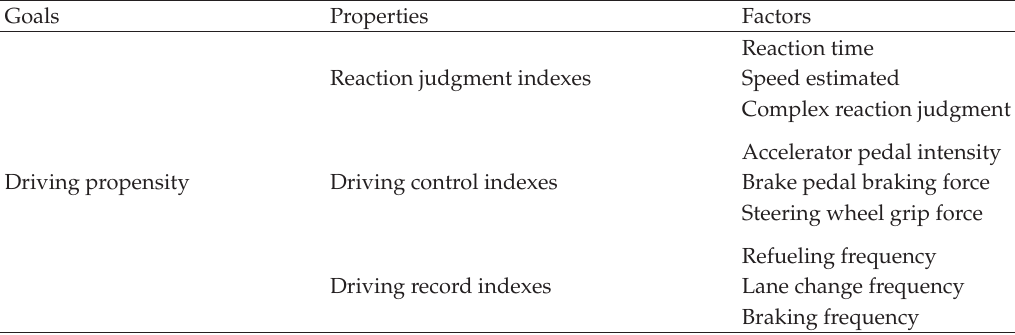
Table 1: Measurement index and